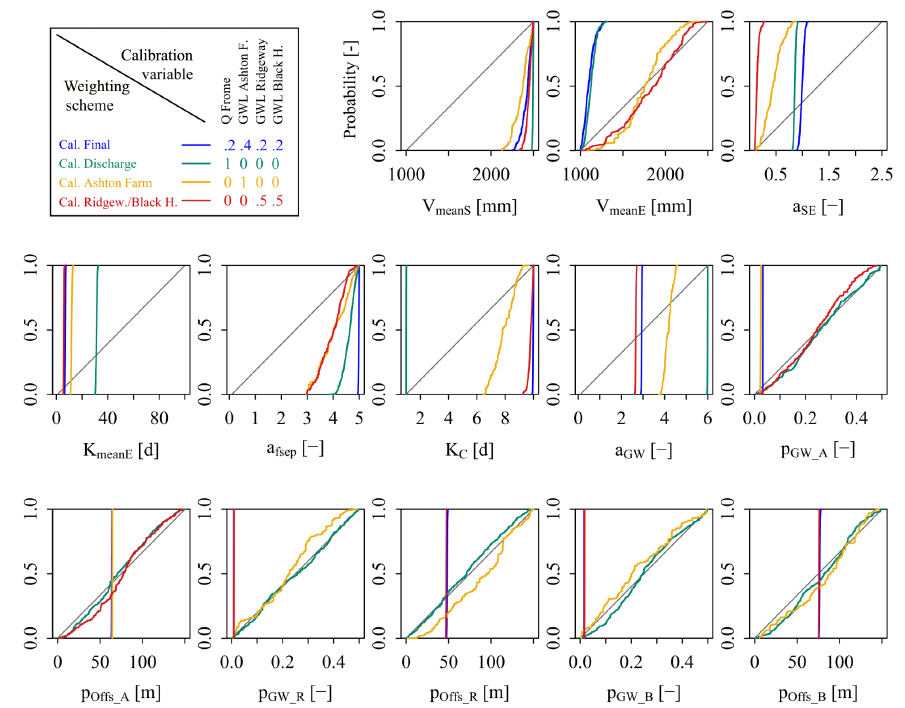
Figure 5. Cumulative parameter distributions (blue) of all model parameters; strong deviation from the 1 : 1 (dark grey) indicates good